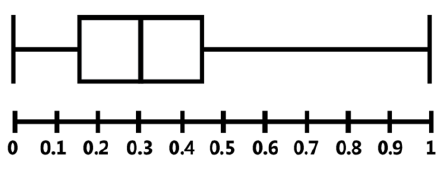
Figure 3. Box plot for subjectivity score of words in STS